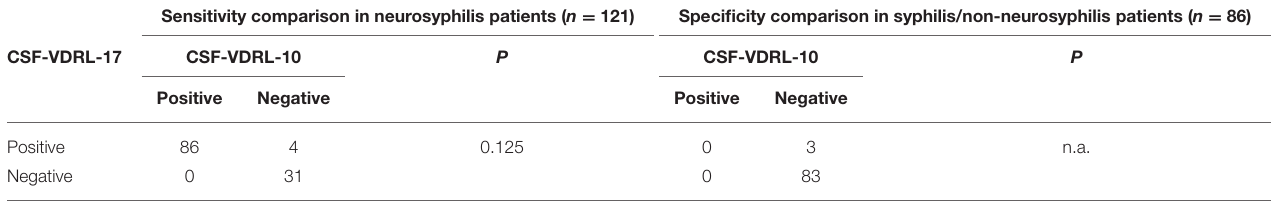
TABLE 2 | Comparison of the sensitivities and specificities between the CSF-VDRL-10 and CSF-VDRL-17 tests for neurosyphilis diagnosis. Sensitivity comparison in neurosyphilis patients ( n = 121) Specificity comparison in syphilis/non-neurosyphilis patients ( n = 86)